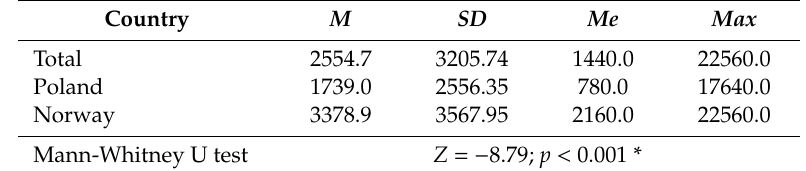
Table 2. Measures of central tendency and dispersion for the MET coe ffi cient for all respondents. Country M SD Total